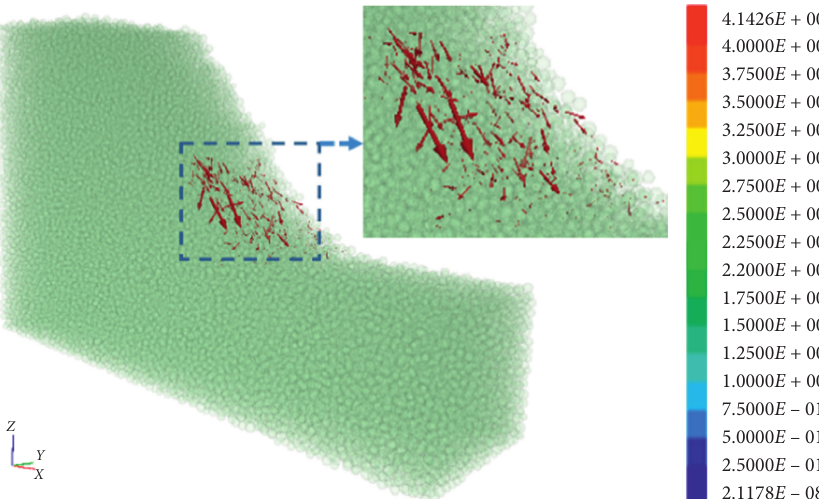
Figure 20: Velocity vector diagram.